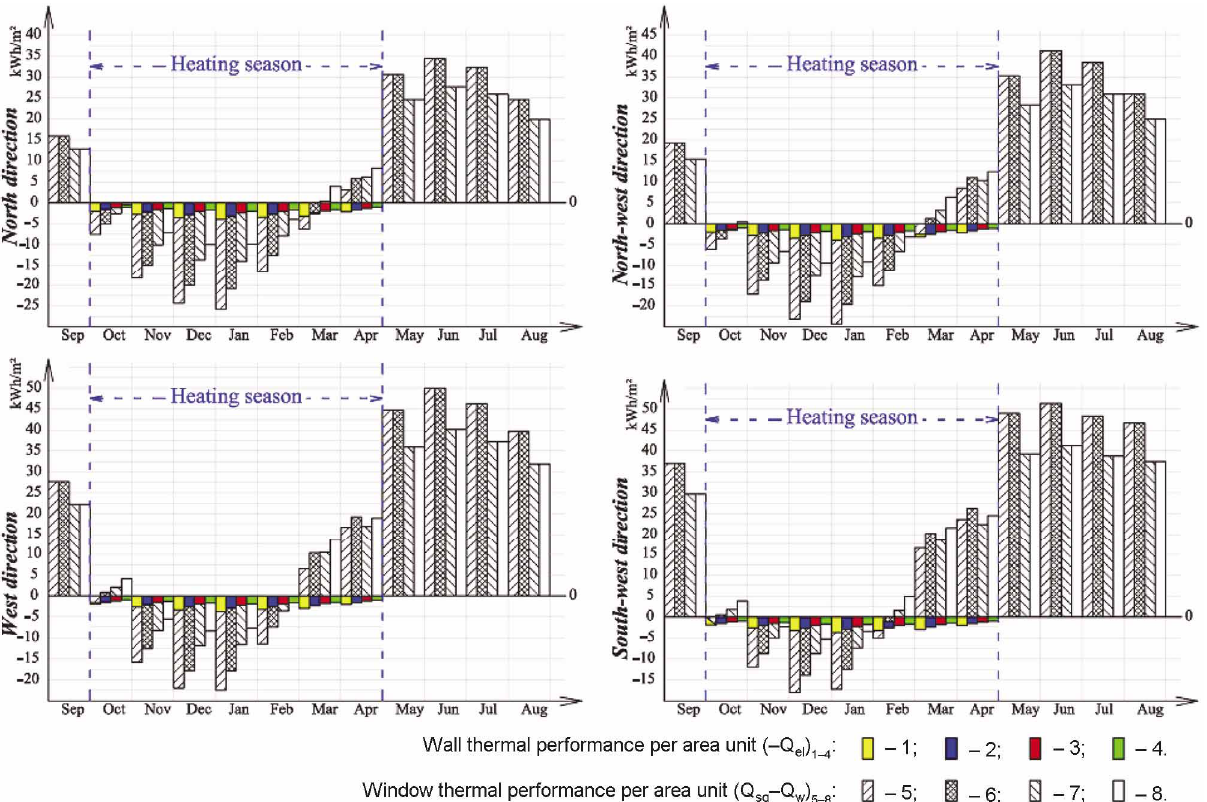
Fig. 4. Representation of the energy balance of windows and walls per area of 1 m 2 oriented to N, N-W, W, S-W: Q sg – solar gains per window area unit; Q w – heat losses per window area unit; Q el – heat losses per wall area